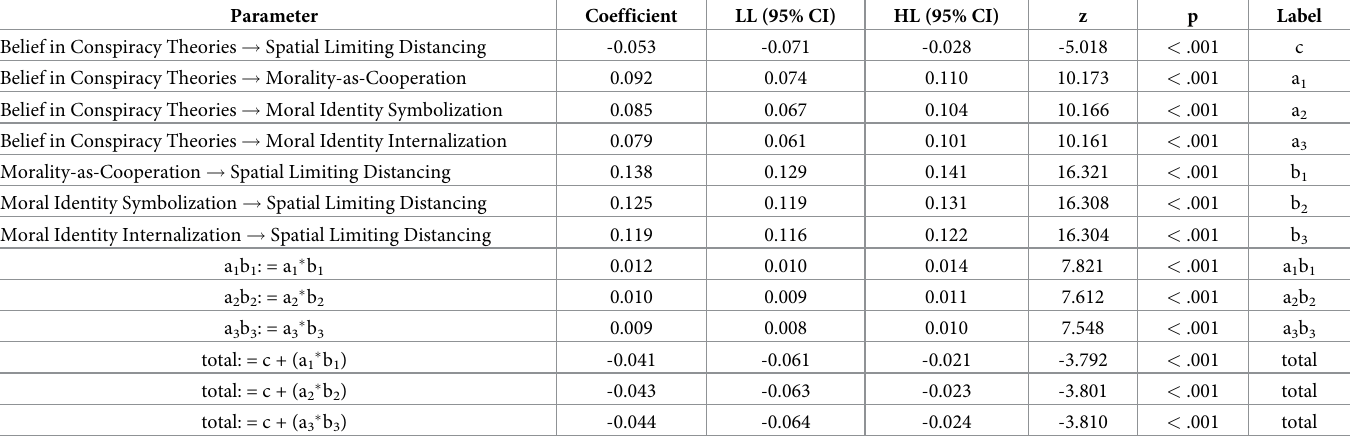
Table 3. Multilevel Mediation Analysis, model 1 (Spatial Limiting